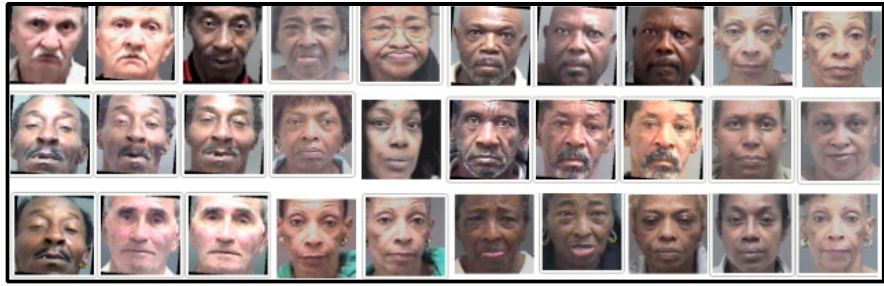
Figure 3. The MORPH dataset. Table 4. The number of images before and after the increment.